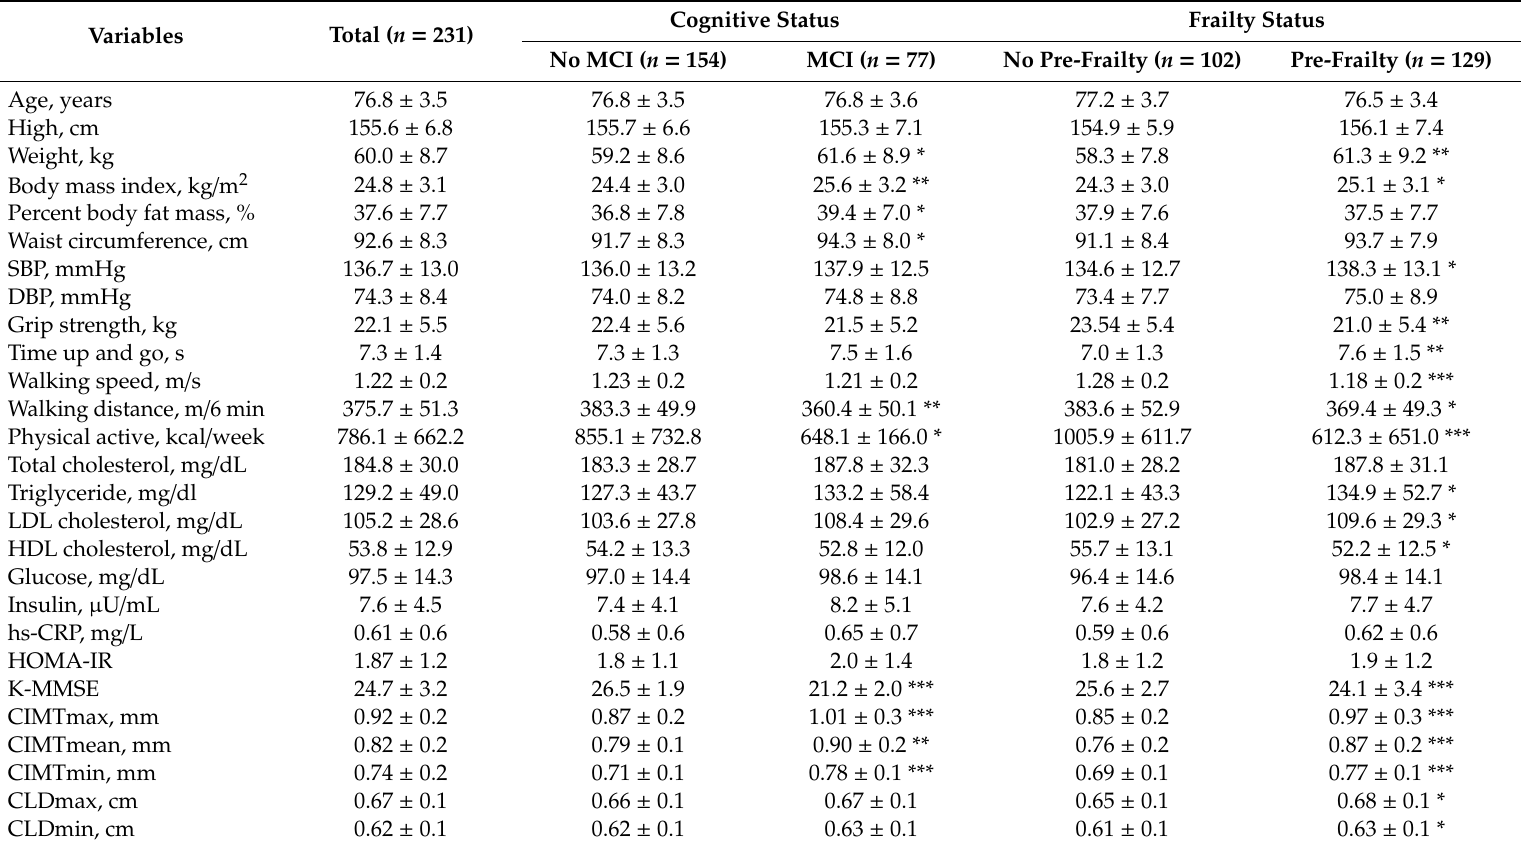
Table 2. Di ff erence between groups of variables according to the cognitive function and frailty status of